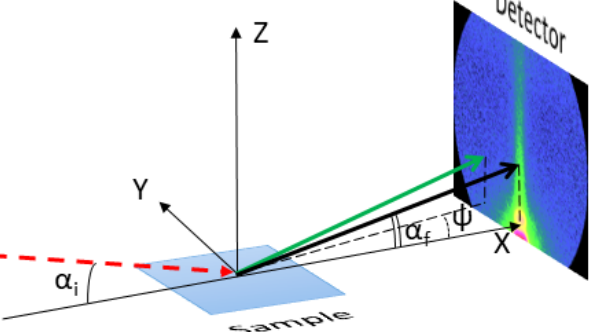
Figure 1. Scheme of grazing incidence scattering experiment. Red dashed and black solid arrows represent incoming and scattered beam, while green solid arrows corresponds to the diffuse scattering. α i , α f , ψ – incidence, scattering and out-of-plane angle,